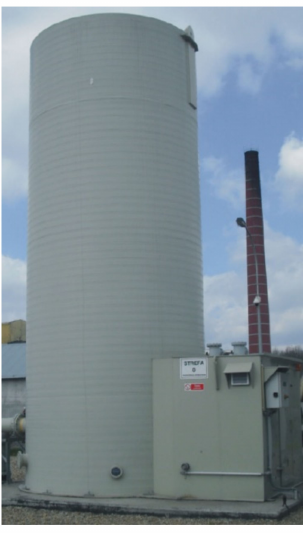
Figure 3. BG desulfurizer in the biogas plant in Liszkowo (photo B.